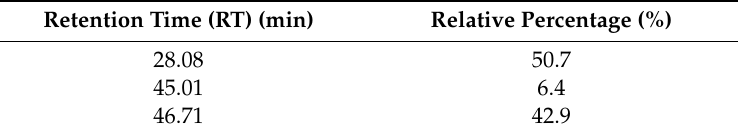
Table 2. Relative composition (%) of F FINAL